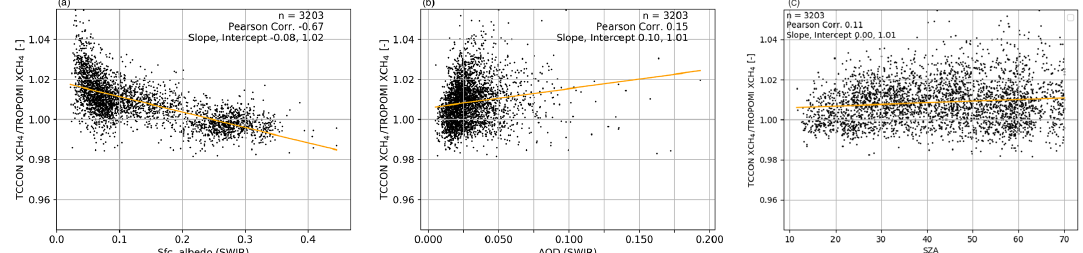
Figure 3. Ratio of XCH 4 measurements by TCCON and TROPOMI as a function of (a) retrieved surface albedo in the SWIR spectral range, (b) retrieved effective aerosol optical depth (AOD) in the SWIR spectral range and (c) solar zenith angle